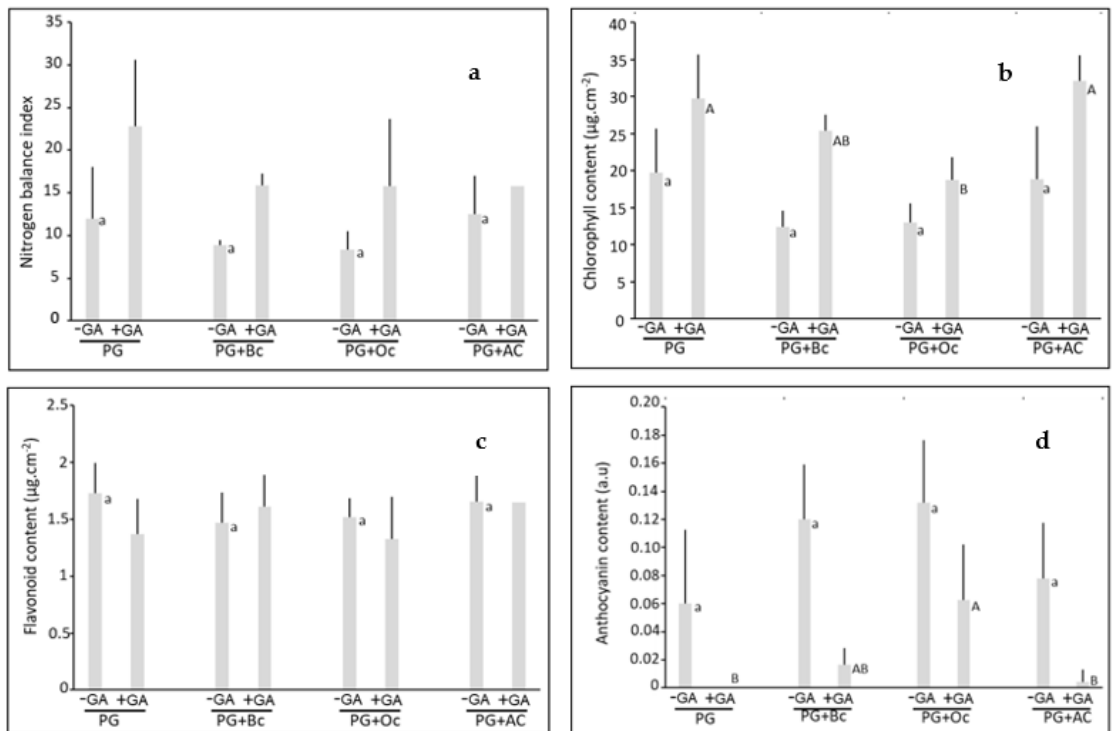
Figure 1. Nitrogen balance index ( a ) and pigment contents (chlorophyll ( µ g.cm − 2 ) ( b ), flavonoid ( µ g.cm − 2 ) ( c ) and anthocyanin (a.u) ( d ) determined on the leaves of Populus × . canescens after 45 days of growth on Pontgibaud technosol alone (PG) or amended with biochar (PG+Bc), ochre (PG+Oc), and activated carbon (PG+AC), associated or not with green amendment (+/ − GA). Small letters indicate a significant difference between the treatments without green amendment while capital letters indicate a significant difference between the conditions with the green amendment ( p < 0.05) (n = 5 ± SE).